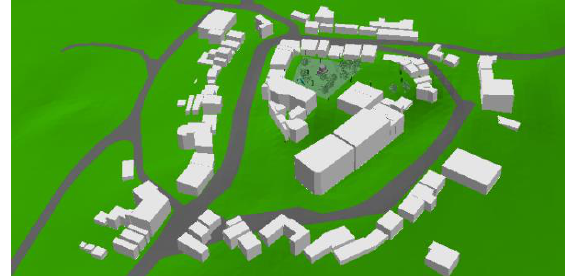
Figure 8. LOD1, “Block model” of old town and neighboring